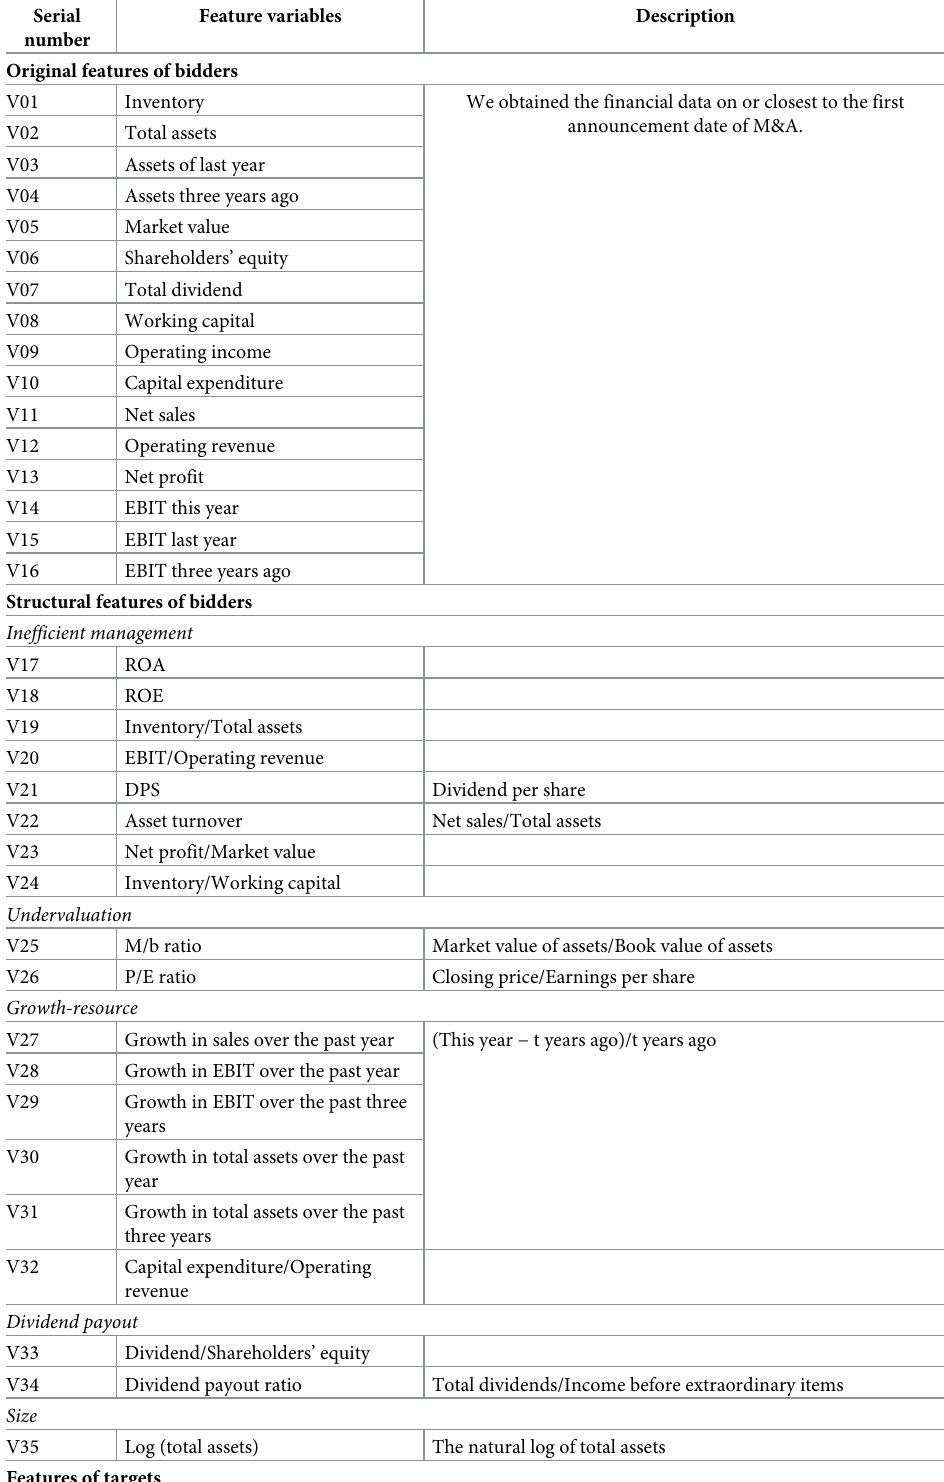
Table 1. Feature